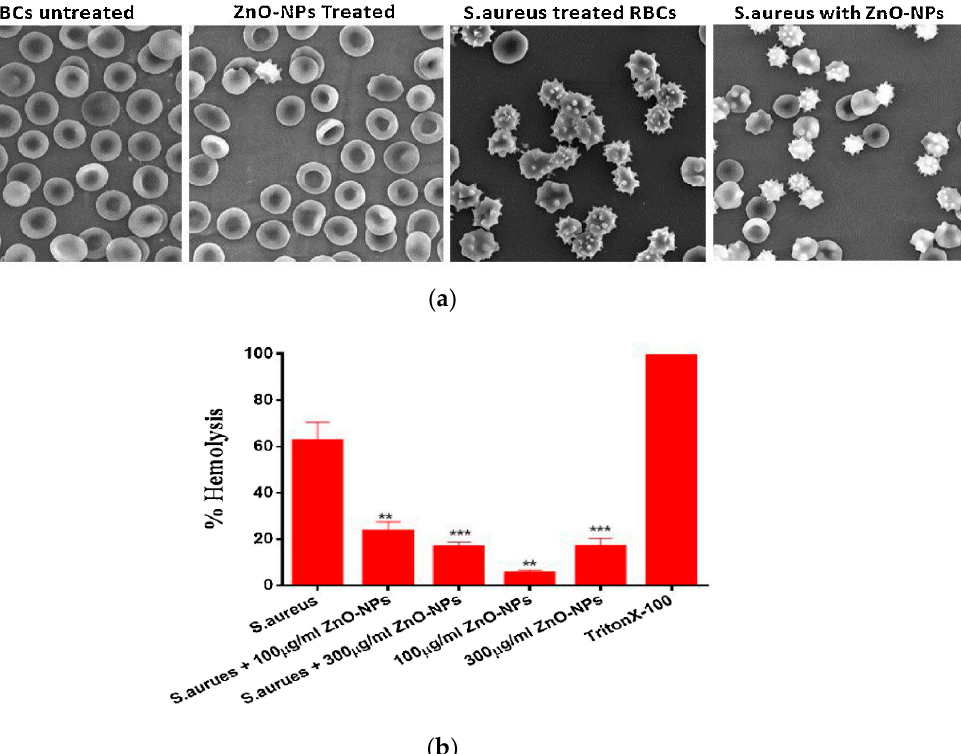
Figure 48. ( a ) SEM images showing lysis of RBCs by S. aureus and their inhibition by green ZnO NPs. Images from left to right: untreated RBCs, ZnO NPs treated RBCs, S. aureus infected RBCs, and RBCs co-cultured with S. aureus and ZnO NPs. ( b ) Inhibition of hemolysis in S. aureus infected RBCs by ZnO NPs. All data are expressed as the mean ± standard deviation. *** for p ≤ 0.001; ** for p ≤ 0.01. Reproduced from [332] under a Creative Commons License.